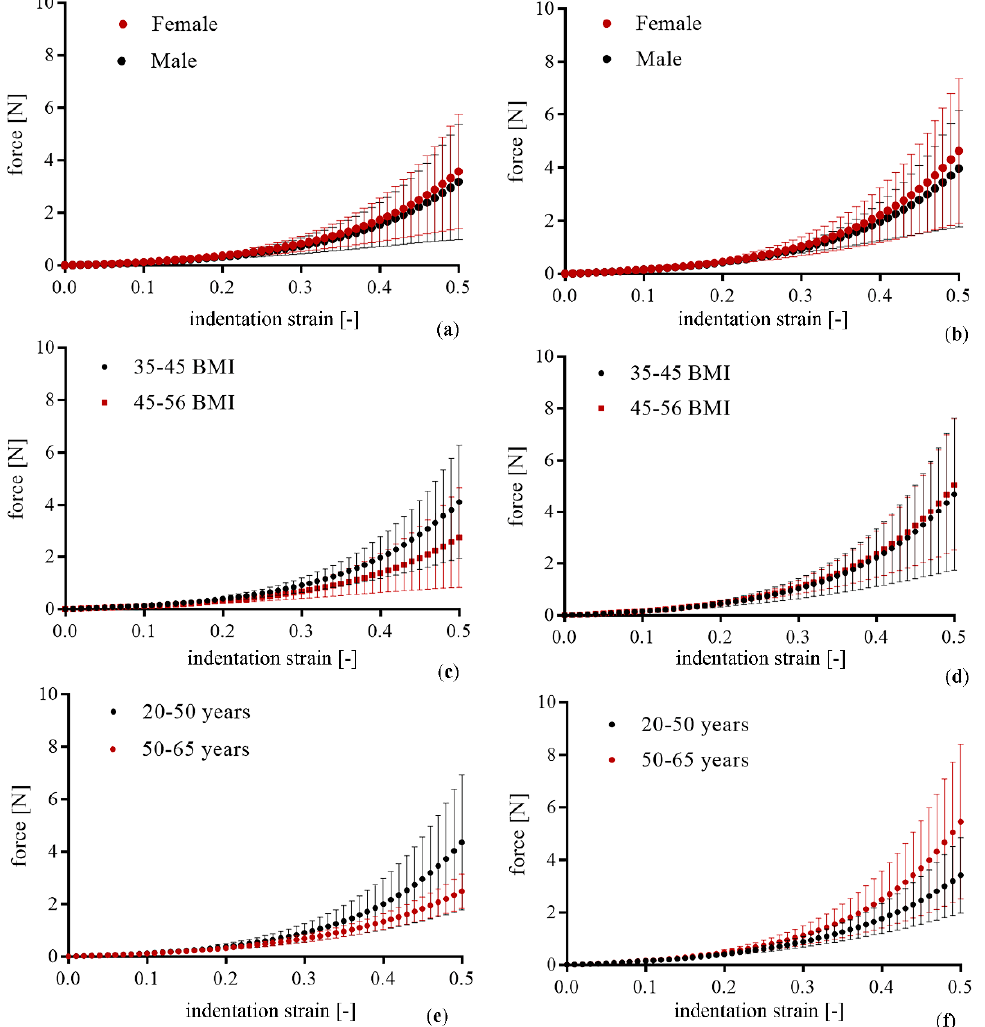
Figure 5. Force vs. indentation strain at equilibrium: tests performed on ( a , c , e ) VAT and ( b , d , f ) SAT specimens, and divided into ( a , b ) male/female subjects, ( c , d ) subjects with different BMI, and ( e , f ) subjects with different ages (mean ± SD).